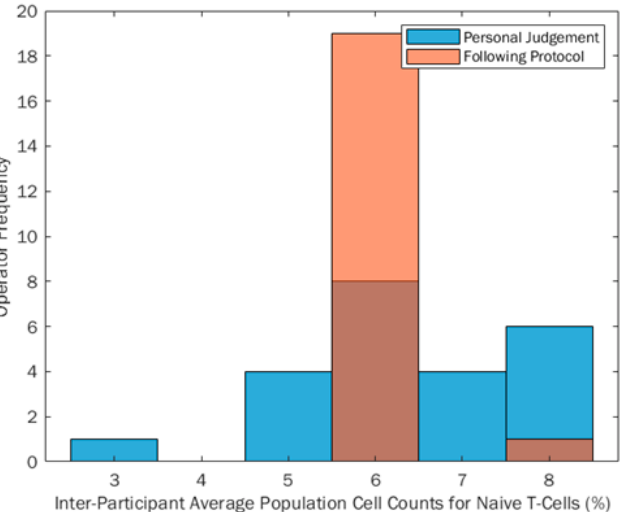
Figure 3. Histograms showing percentage cell counts (shown as a percentage as a function of total cells in the sample) reported when participants gate using their own judgement (blue bars) and when following a protocol (orange bars).